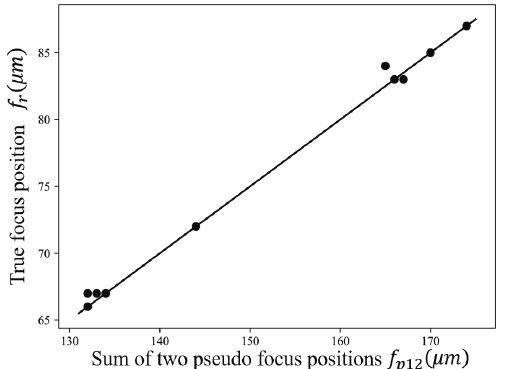
Figure 9. Distribution of the sum of two pseudo focus positions and real focus